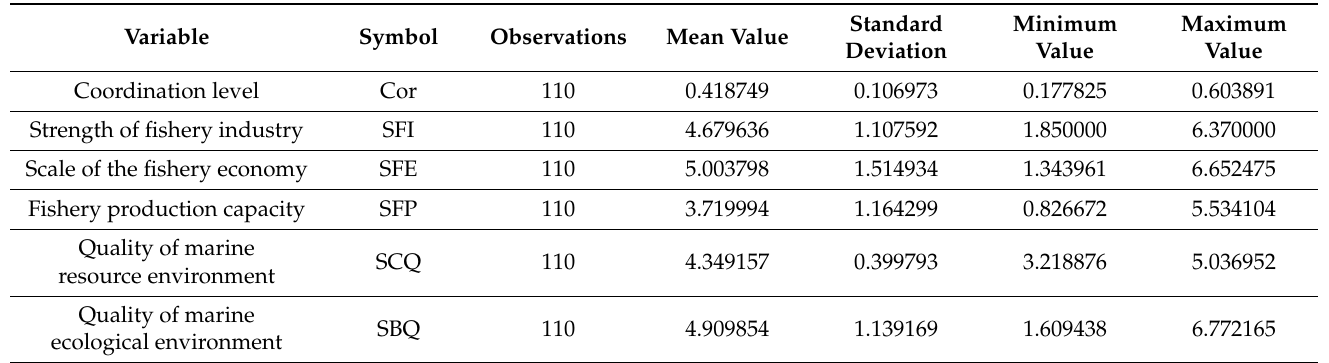
Table 6. Descriptive statistics of the